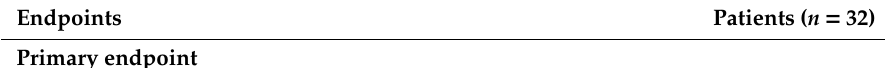
Table 2. Clinical outcomes during the overall analysis period. Table 2 . Clinical outcomes during the overall analysis period